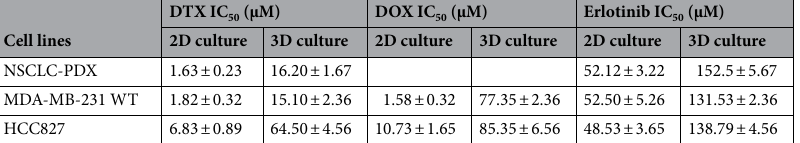
Table 2. Cytotoxicity of DTX, DOX and Erlotinib in 2D monolayers and 3D spheroids of NSCLC-PDX, MDAMB-231 WT, and HCC-827 cells. DOX was not used for NSCLC PDX cells due to its lack of effectiveness against lung cancer. The experimental results were expressed as mean ± standard